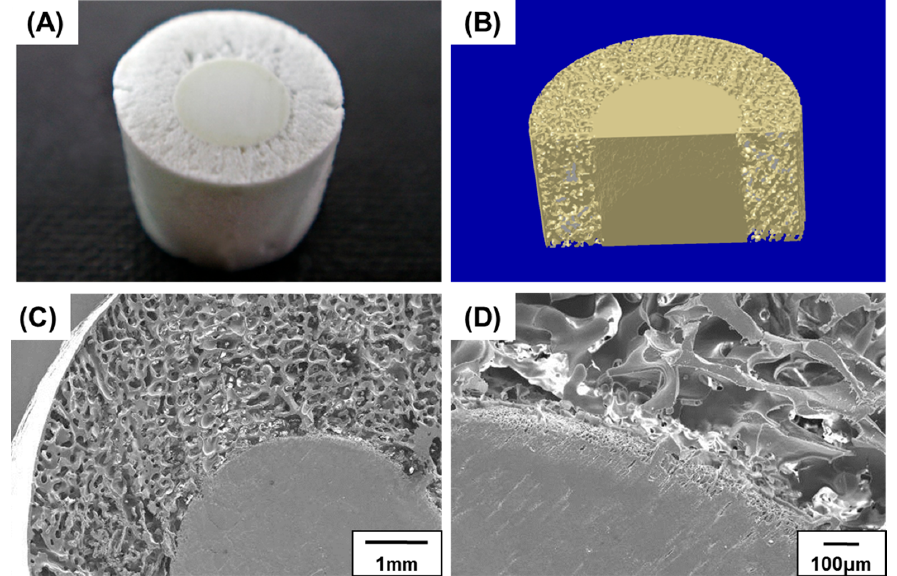
Figure 11. ( A ) Optical; ( B ) micro-CT; and ( C , D ) SEM images of a porous hydroxyapatite (HA) scaffold possessing a dense internal core and porous outer layer.